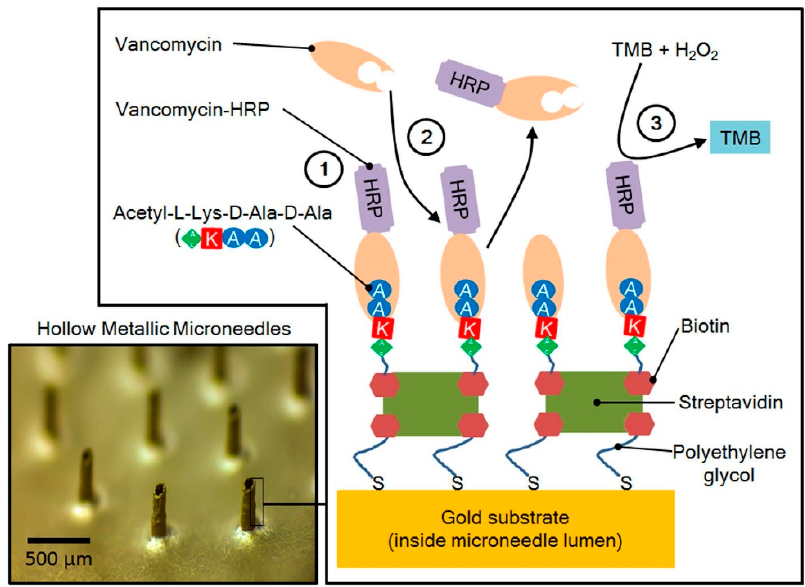
Figure 2. Functionalization of gold-coated hollow microneedle lumens for fluid collection, drug binding, and detection. Figure obtained from Ranamukhaarachchi et al. with permission [6].